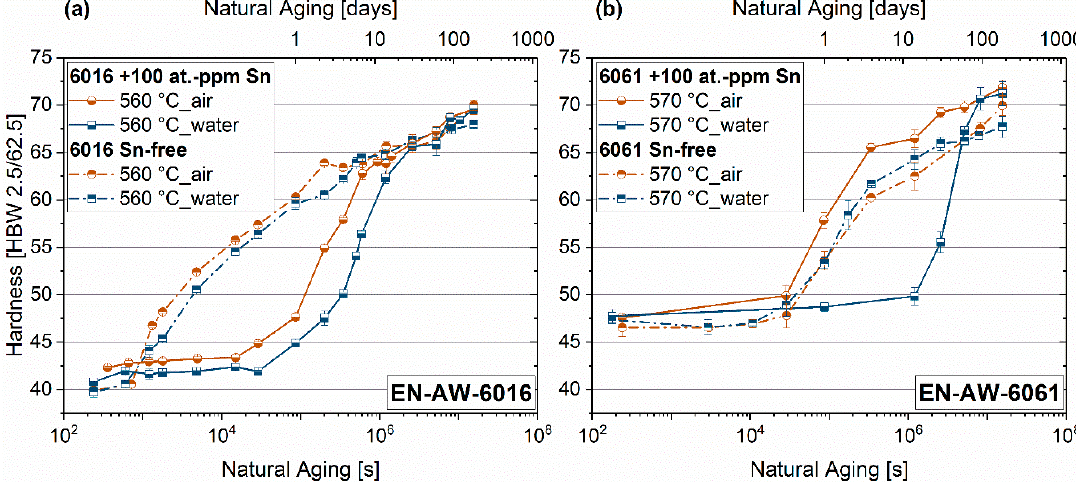
Figure 3. Natural aging behavior over six months of EN-AW-6016 and EN-AW-6061, which contains 100 at.-ppm Sn (solid line) and Sn-free (dot-dashed line). EN-AW-6016 ( a ) and EN-AW-6061 ( b ).